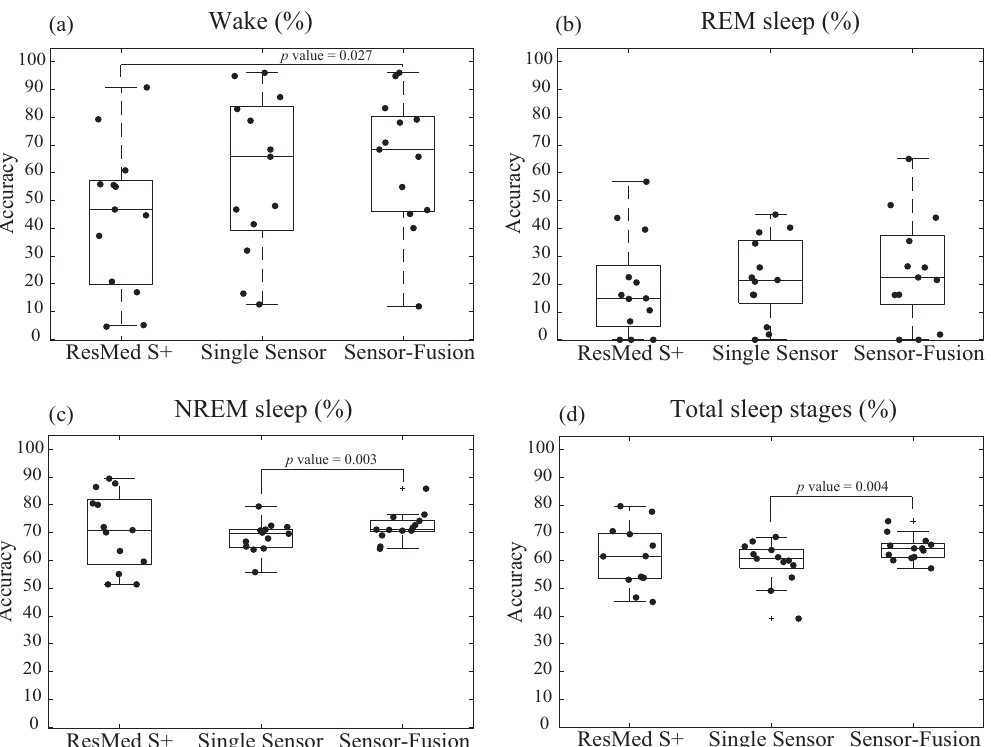
Figure 8. The box plots of: ( a ) wake; ( b ) REM sleep; ( c ) NREM sleep; ( d ) total sleep stage classification of 13 tested subjects. The x axis and y axis respectively represent the tested sleep monitoring algorithms, and the accuracy (%) with respect to the polysomnographic reference data. The line at the center of the box represents the median, and the upper and lower edges of the box represent the 75th and 25th percentiles. The ends of the whiskers represent 90th and 10th